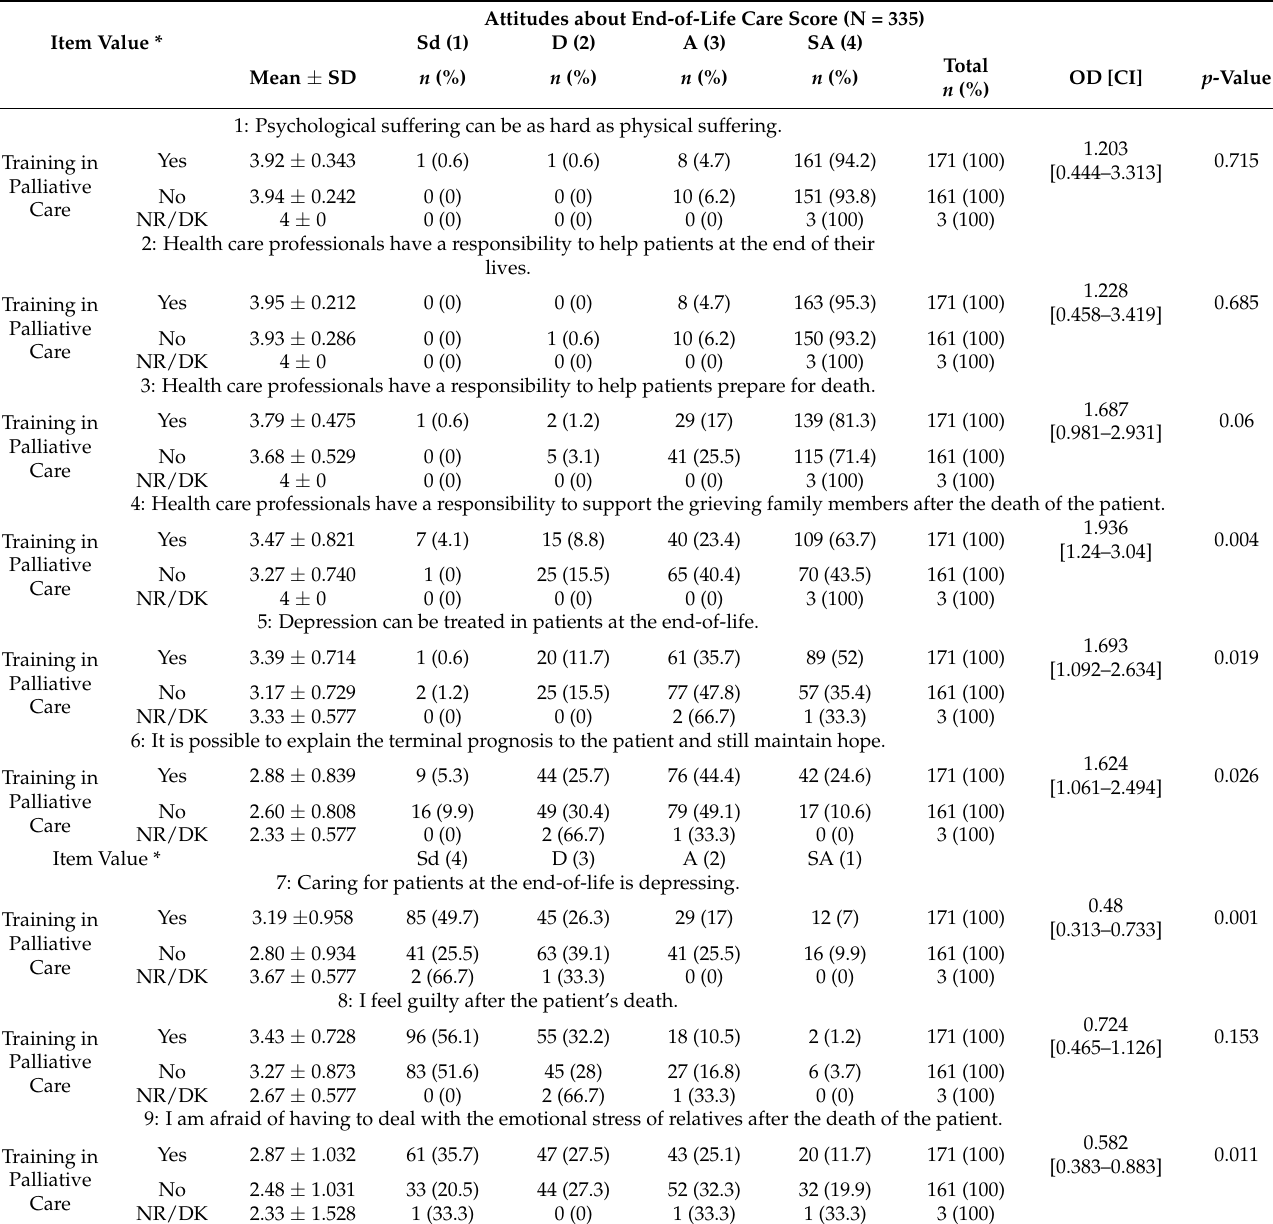
Regarding attitudes toward end-of-life care (Table 5), the results showed a more posi- tive attitude and a higher mean score in the trained group (3.43 ± 0.37 versus 3.21 ± 0.32), the difference being statistically significant ( p < 0.001). Table 5. Score of Attitudes about End-of-Life Care and Training in Palliative Care. Attitudes about End-of-Life Care Score (N = 335) Item Value * Sd (1) D (2) A (3) SA